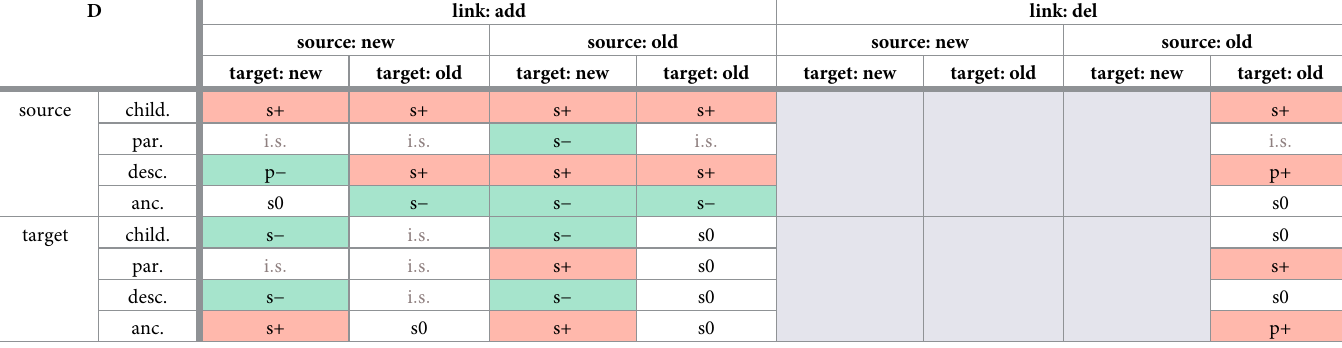
Table 2. Summary of the results for hierarchy D. The columns of the table correspond to the studied different link types, and the rows indicate the studied node property on either the source (top 4 rows) or the target (bottom 4 rows). The 3 rd , 4 th and 5 th columns correspond to impossible link types, therefore, are left empty. The entries in the cells correspond to the following abbreviations: ‘s+’, ‘s0’ and ‘s-’ for strong indication of preference, no preference and anti-preference, ‘p+’ and ‘p-’ for indication of preference or anti-preference with a peak, and ‘i.s’ for insufficient